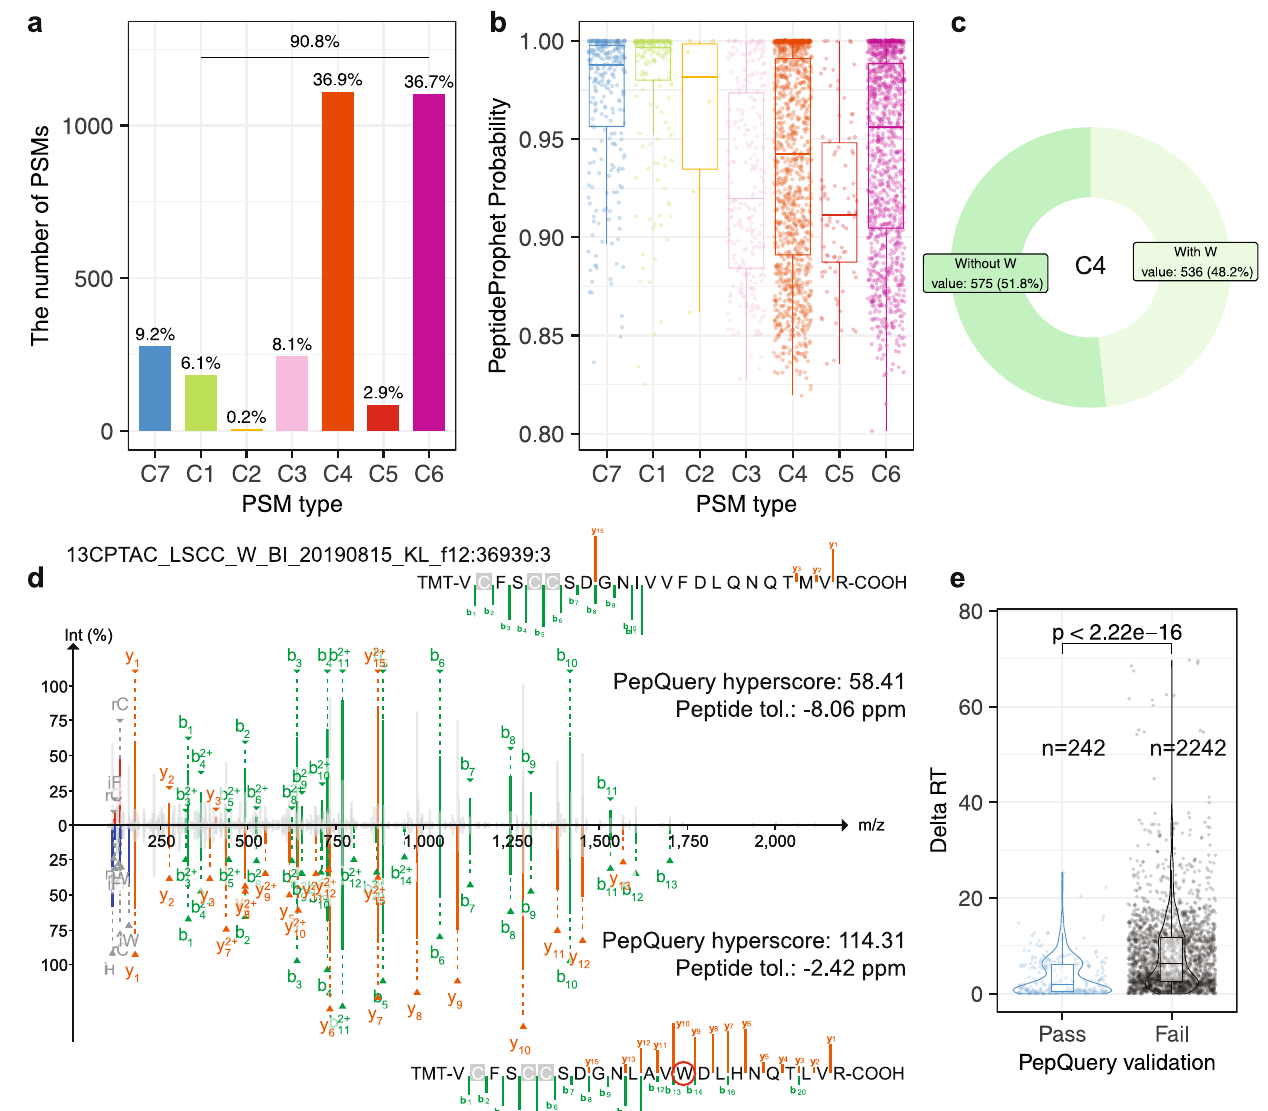
Fig. 3 | Validation of novel peptide identi fi cations. a PepQuery2 classi fi ed pre- viouslyreportedPSMssupportingnovelpeptidesresultedfromWtoFsubstitution intosevencategoriesasdescribedinFig.1,andonlyC7PSMspassedthevalidation. b PeptideProphet probability distributions for different categories of the PSMs. c ThepercentagesofPSMs( C4 )fromW2Fpeptidesinwhichthespectrummatched equally or better to a reference peptide with or without containing amino acid W. d The spectrum originally matched to a W2F peptide has better match to a